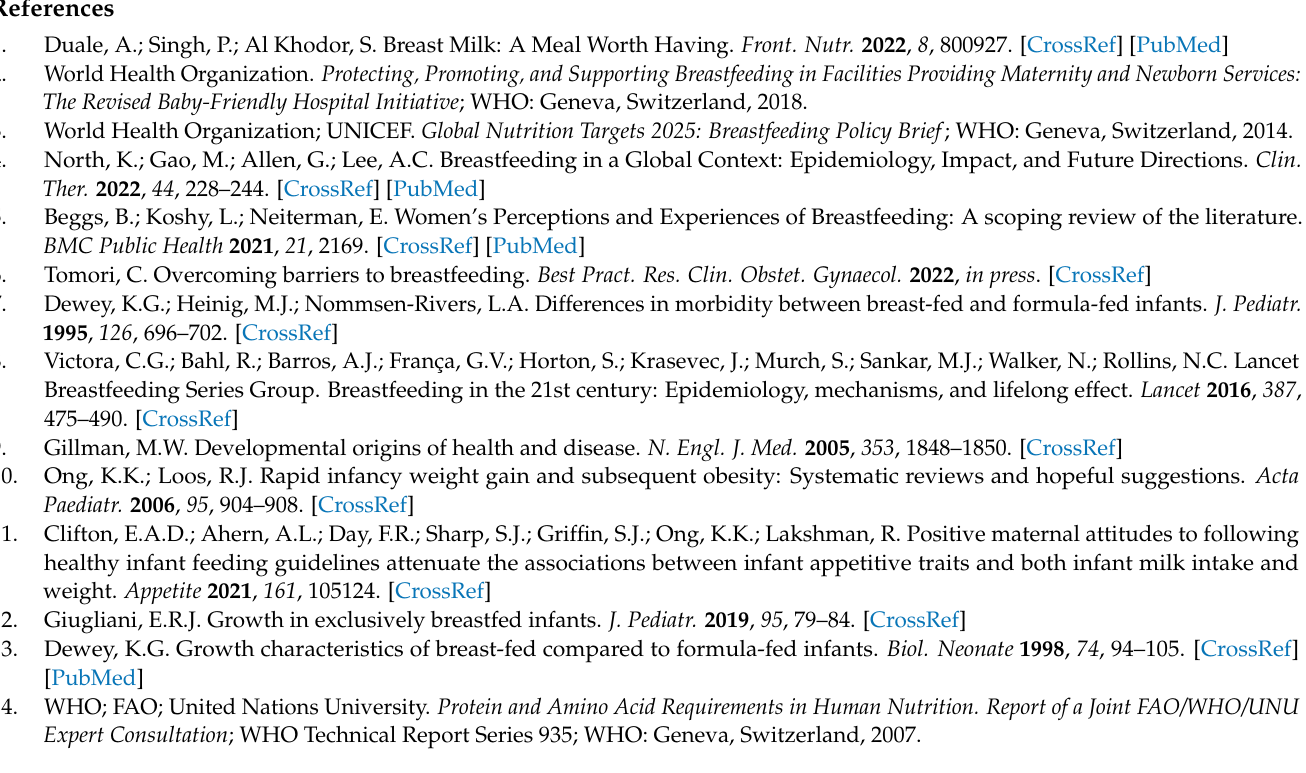
Table S1: Inclusion and exclusion criteria for selecting articles (PICOS); Table S2: Characteristics of included